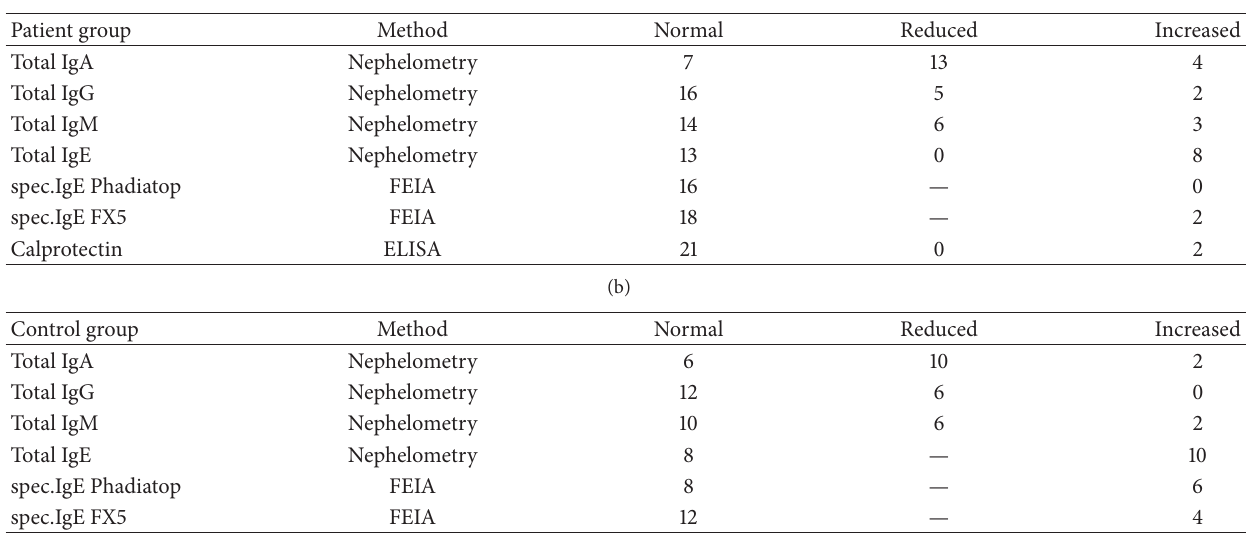
Table 4: Total immunoglobulin levels and specific IgE (Phadiatop and